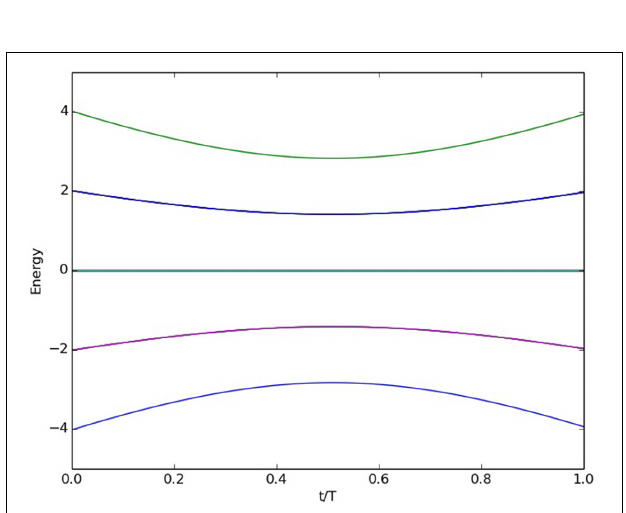
FIGURE 2 | Time-dependent eigenspectrum for p = 4 orthogonal memories stored in a network of n = 4 neurons in the presence of bias. We define θ in terms of the first input memory and (cid:6) = 1. For orthogonal memories, the spectrum is the same for the Hebb, Storkey, and projection learning